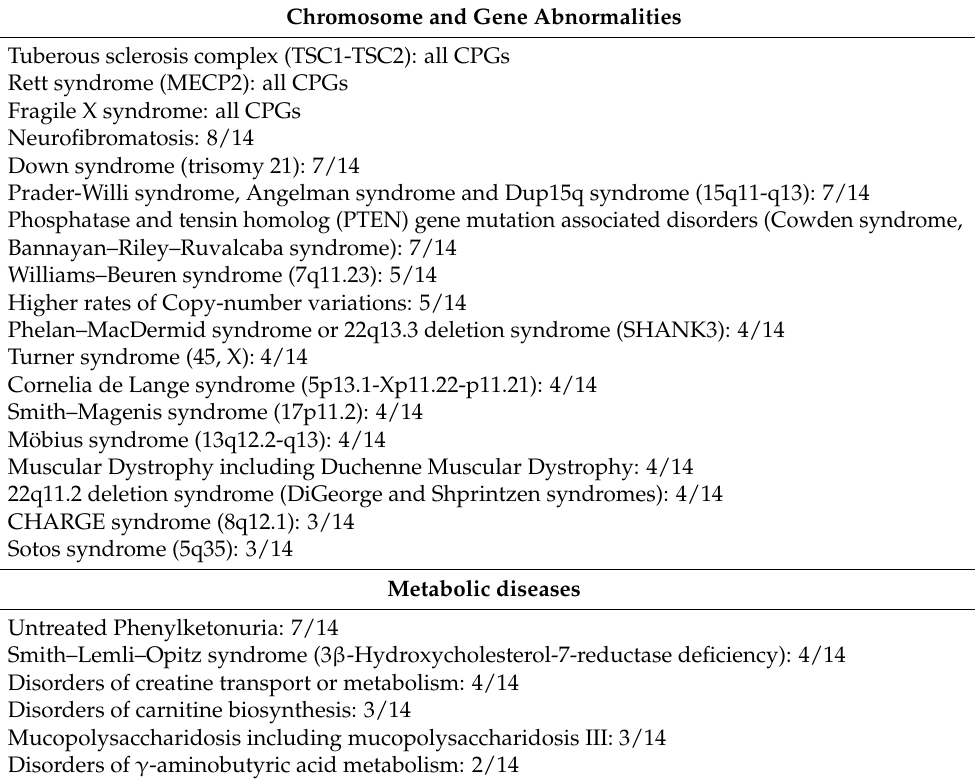
Table 3. Most often reported chromosome and gene abnormalities, and metabolic diseases. Chromosome and Gene